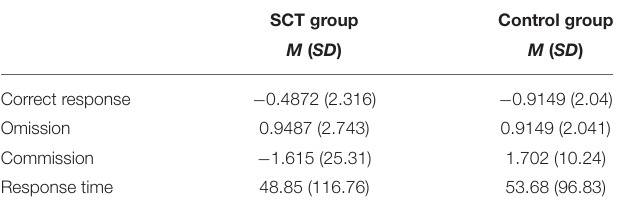
TABLE 2 | Mean and standard deviation of CCPT measures in the SCT and control groups.